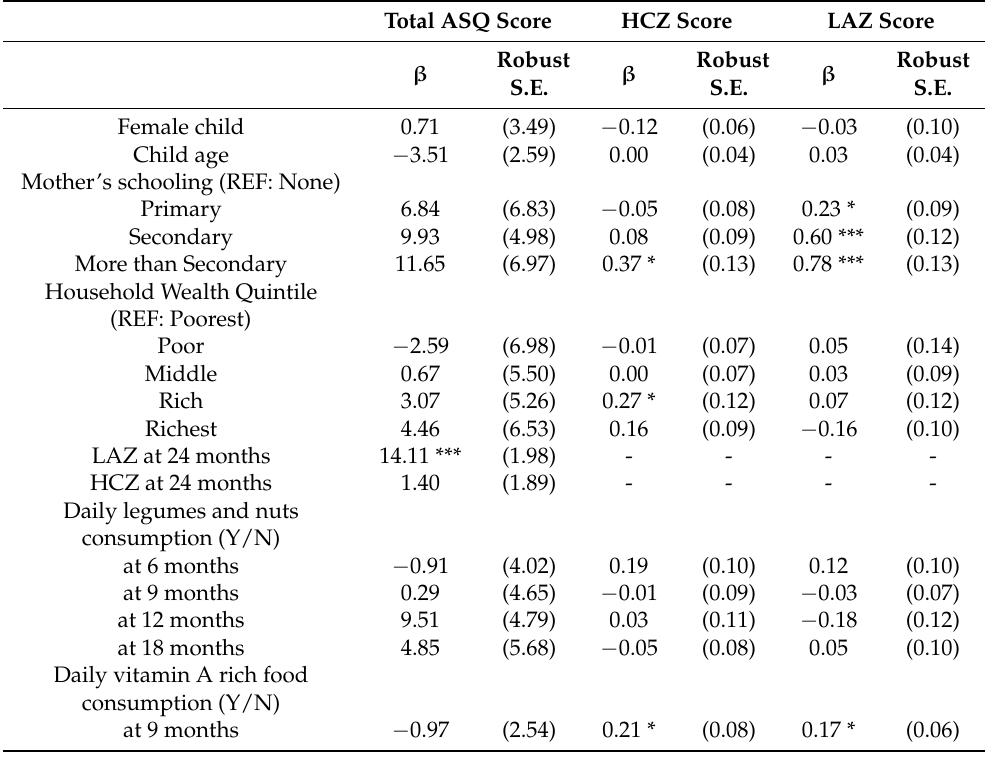
Table A1. Association of Total ASQ scores, HCZ, LAZ and daily consumption (Y/N) of all food